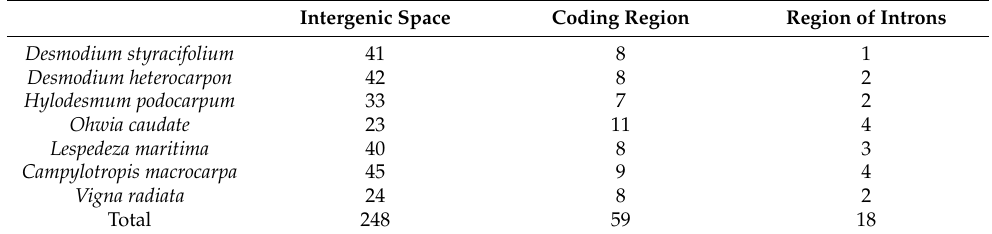
Table 2. Tandem repeat distribution among six Desmodieae species and an outgroup (Vigna).